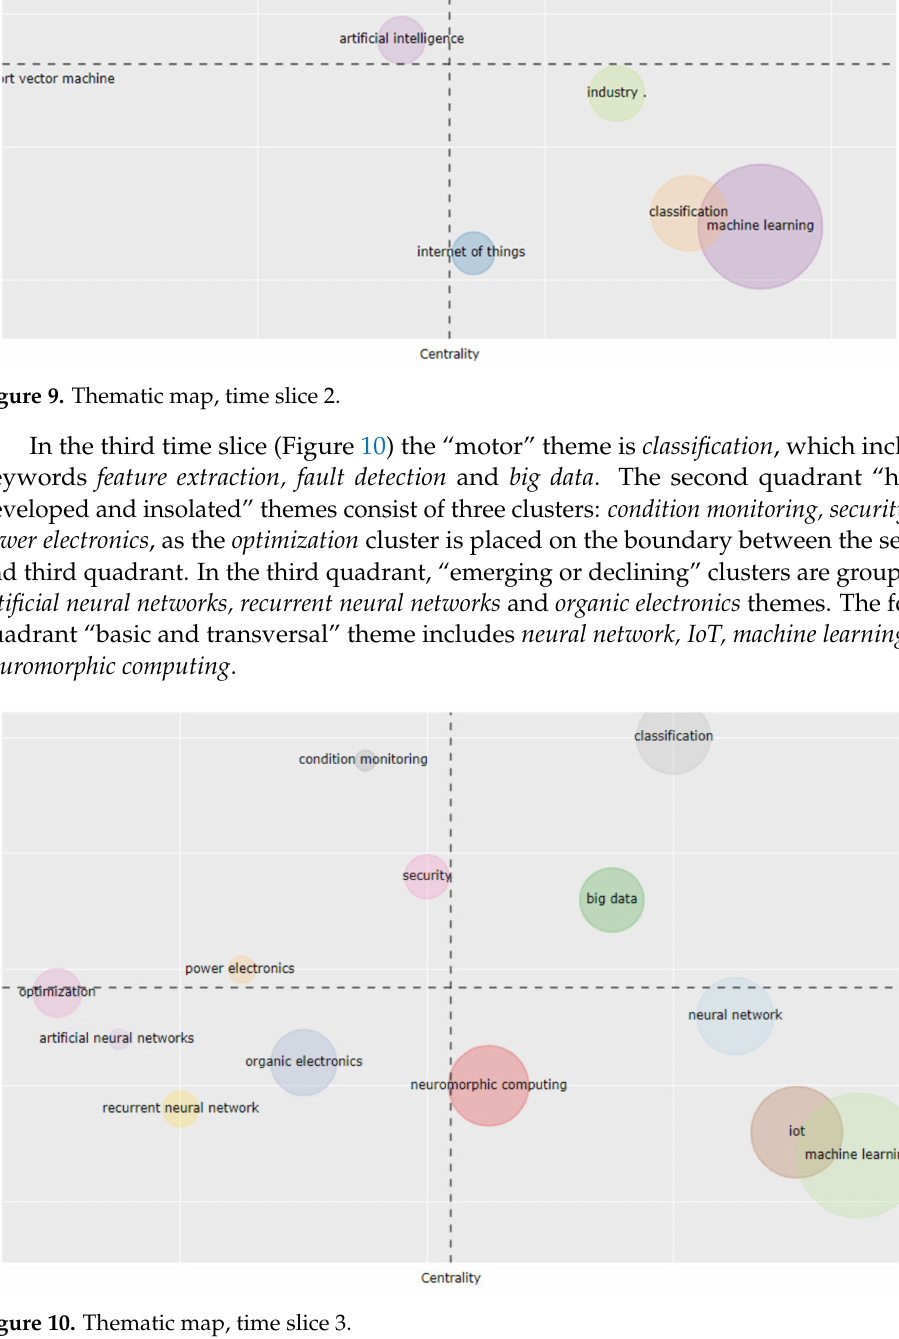
Figure 10. Thematic map, time slice